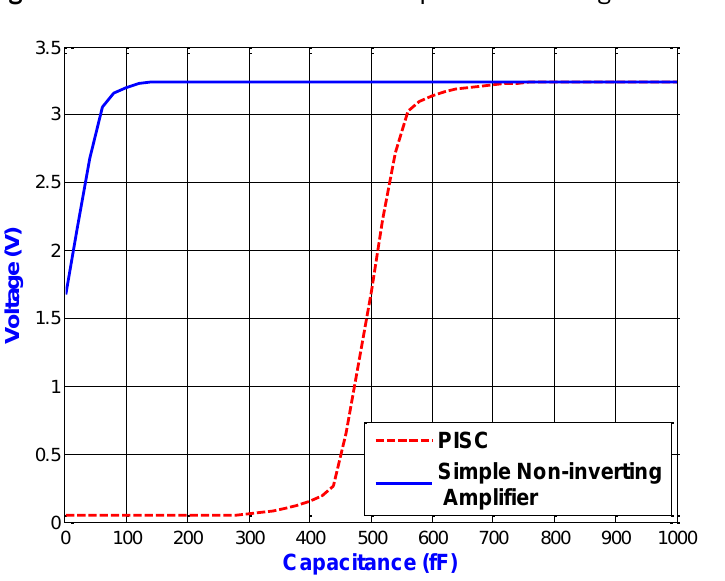
Figure 13. C-V curves of the two capacitive sensing circuits.